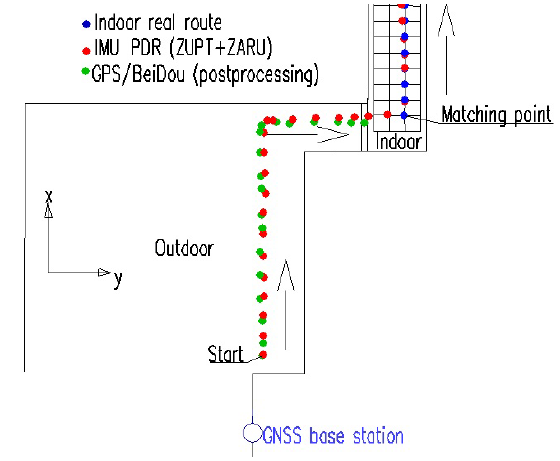
Figure 5. IMU PDR (ZUPT + ZARU) and GPS/Beidou results (outdoor